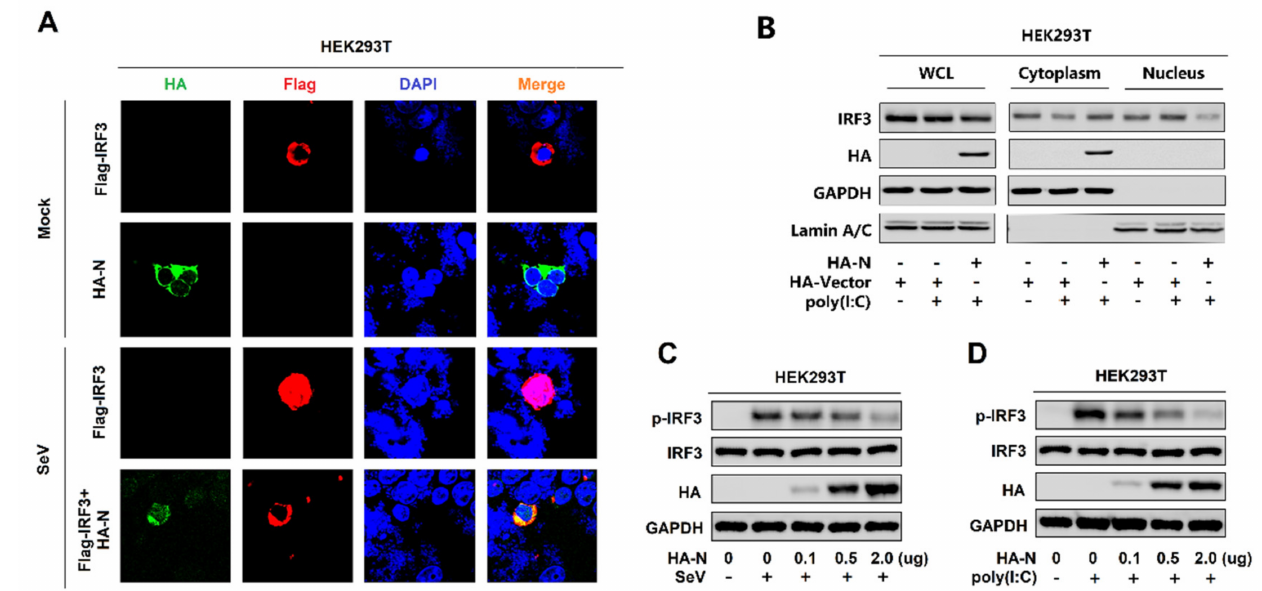
Figure 3. SARS-CoV-2 N protein restricts IRF3 phosphorylation and nuclear translocation. ( A ) HEK293T cells were transfected with pFlag-IRF3 or pHA-N or co-transfected with pFlag-IRF3 and pHA-N for 24 h and infected with SeV (MOI = 0.1) for 16 h. The sub-cellular localizations of Flag-IRF3 (red), HA-N (green), and nucleus marker DAPI (blue) were analyzed by confocal microscopy. ( B ) HEK293T cells were transfected with pHA-N for 24 h and treated with poly(I:C) (2 µ g/mL) for 16 h. IRF3 in the nuclear fractions or the cytoplasmic was determined by immunoblotting analyses. GAPDH served as a cytoplasmic control and Lamin A/C served as a nuclear protein control. ( C , D ) HEK293T cells were transfected with pHA-N for 24 h and ( C ) infected with SeV (MOI = 0.1) for 16 h, ( D ) treated with poly(I:C) (2 µ g/mL) for 16 h. Phosphorylated IRF3, total IRF3, and GAPDH were subjected to Western blotting with the indicated antibodies anti-pIRF3, anti-IRF3, anti-HA, and anti-GAPDH,